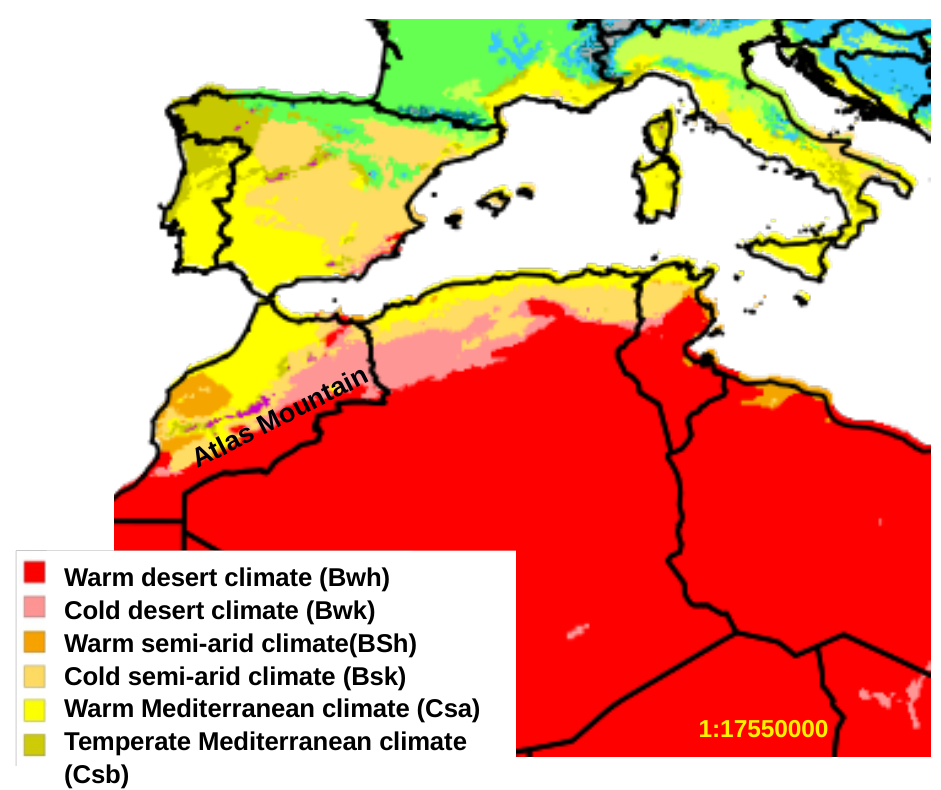
Figure 1. Climate types over North Africa based on the Köppen–Geiger climate classification system, 1980–2016 (https: // commons.wikimedia.org / wiki /